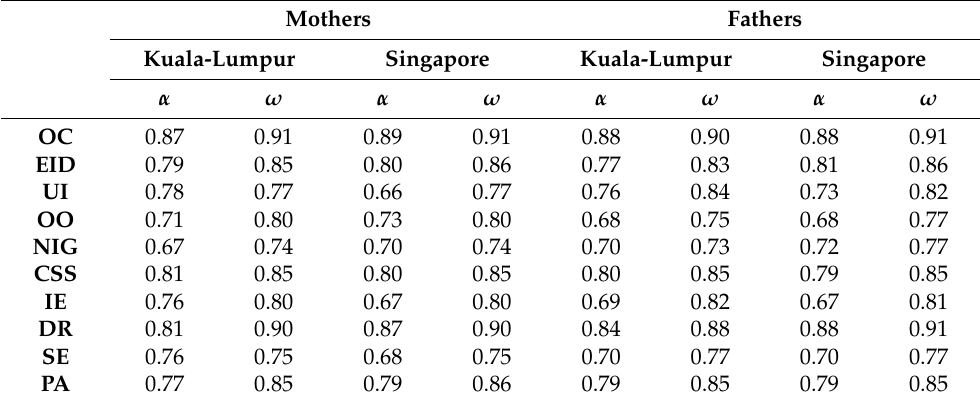
Table 5. Reliability values of α and ω of YPI-R3 subscales using samples with ratings for fathers